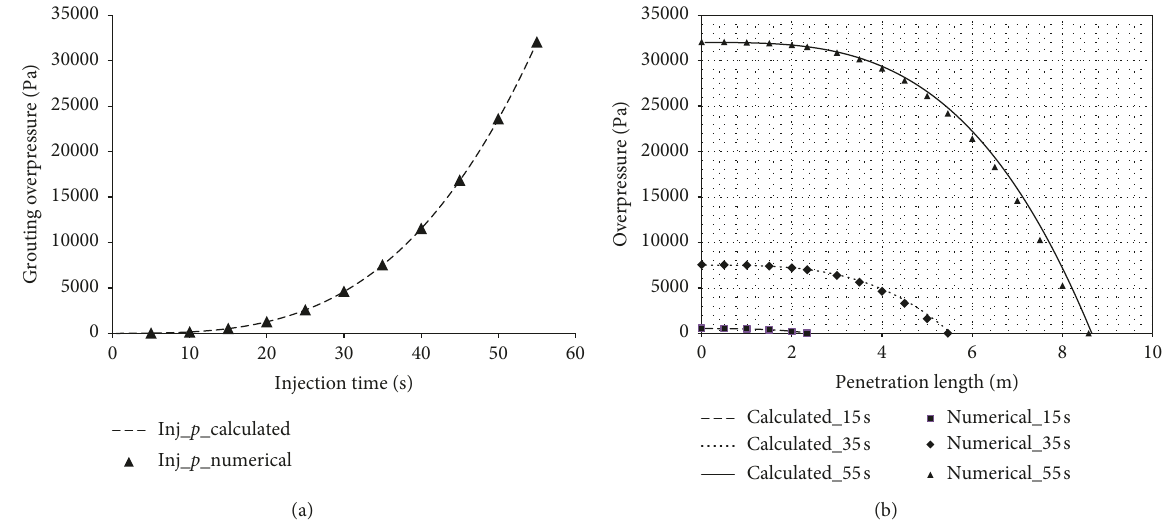
Figure 10: Comparisons of the calculated results and numerical simulation results under flow rate control conditions. (a) Variation in grouting overpressure with injection time. (b) Overpressure distribution in the grouted zone for the CSG at three grouting times, 15, 35, and